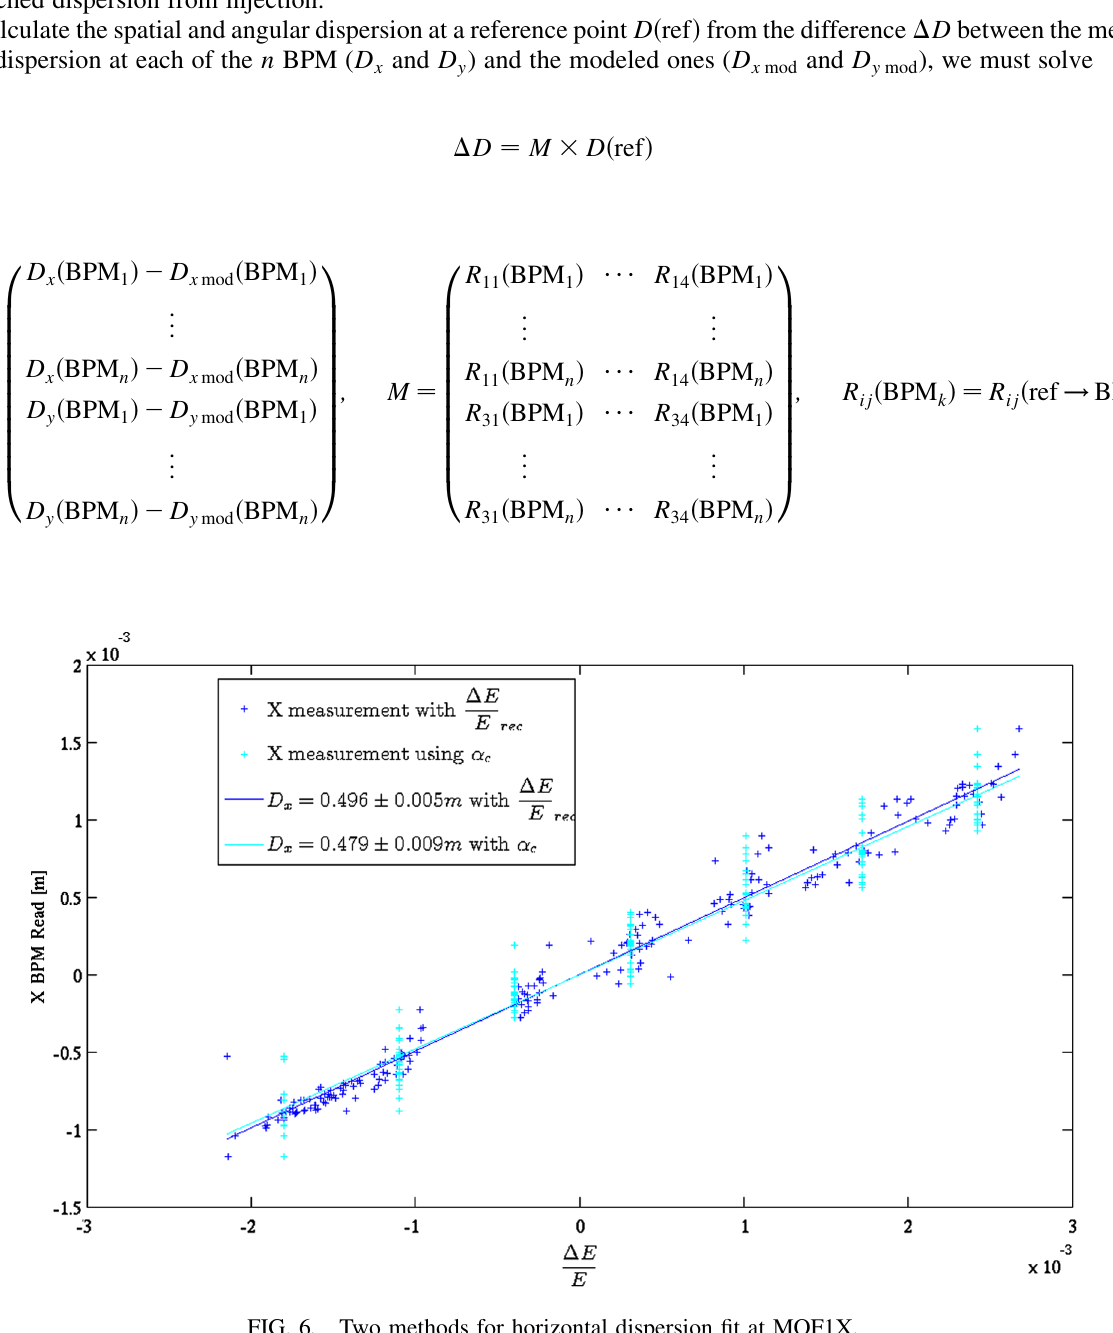
FIG. 6. Two methods for horizontal dispersion fit at